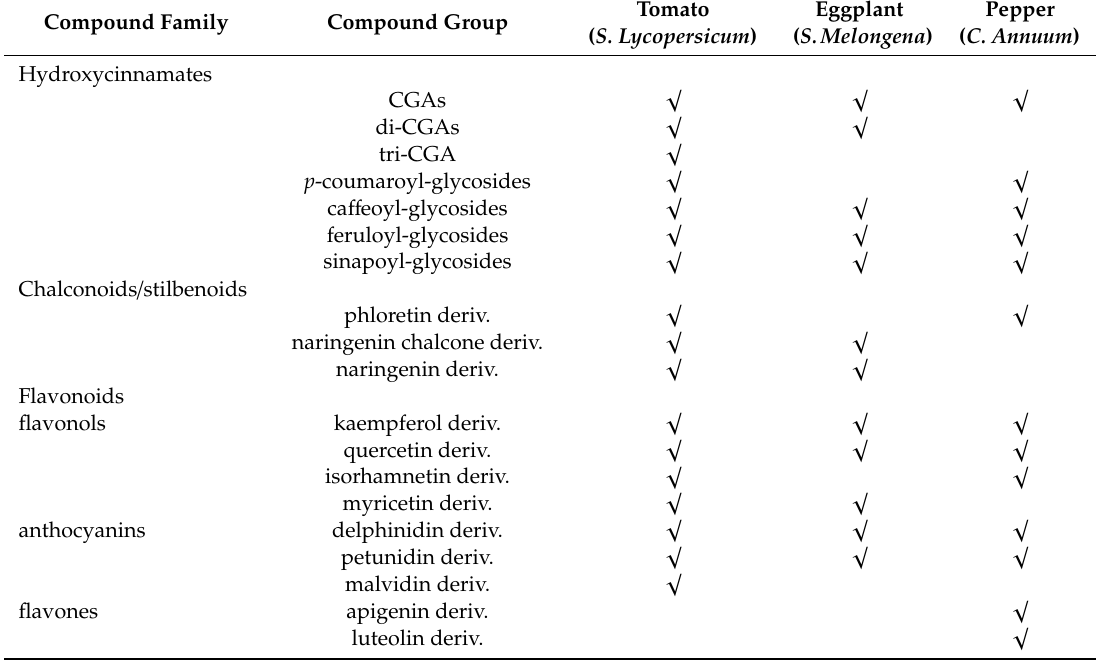
Table 1. Major polyphenolic compound groups reported in the solanaceous